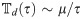
(a) The probability density function (pdf) of residence times of a cargo on a microtubule, ψ(τ), for an ensemble of N = 6 motors (solid curve) calculated using Eq (4) with a particular set of pi and λi. We chose pi such that ∑i
pi = 1. The dashed curve is the power-law fit ψ(τ) ∼ Aτ−μ−1 with μ = 1.4 and A = 0.012. This power-law pdf corresponds to the rate Td(τ)∼μ/τ, which is consistent with the long time behaviour of Eq (6). Notice that 12 parameters (pi and λi) are parametrized by only two parameters A and α. (b) The time averaged variances TAVARs (the time averaged mean squared displacements corrected for the drift) calculated along single trajectories generated with the residence times of the cargo on the microtubule shown in (a) grow as Δ3−μ = Δ1.6 (red dashed-double-dotted curve).